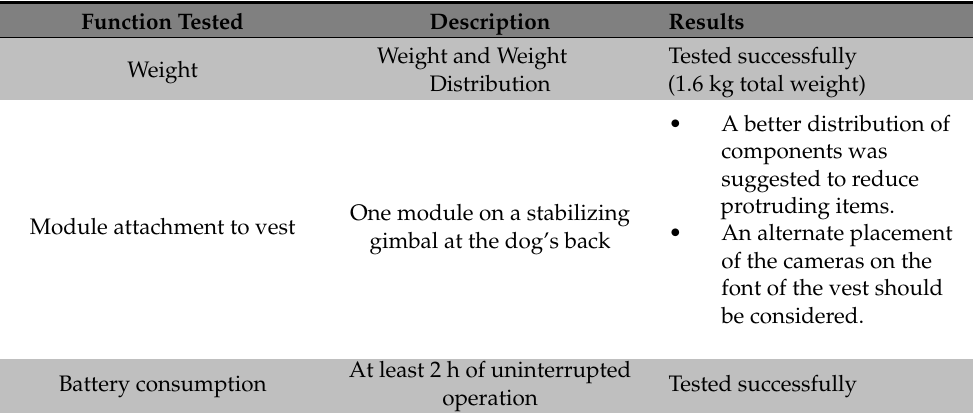
Table 1. Summary of the first round of